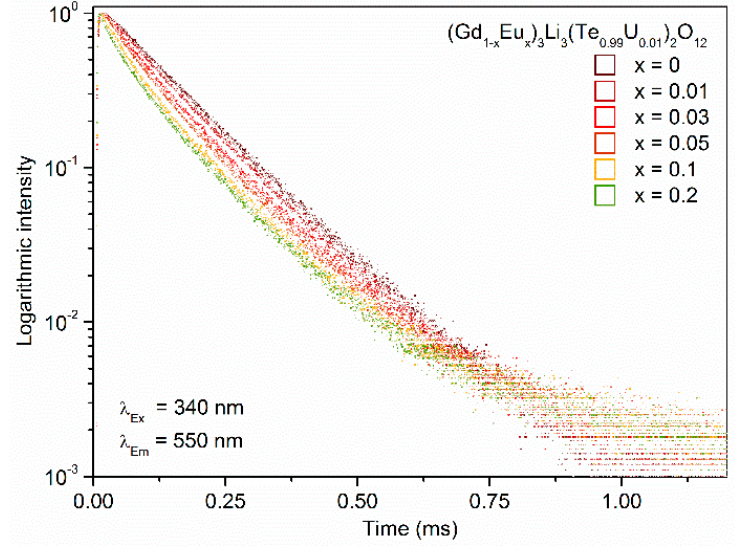
Figure 10. Fluorescence lifetime curves of (Gd 1 − x Eu x ) 3 Li 3 (Te 0.99 U 0.01 ) 2 O 12 with 0 ≤ x ≤ 0.2 upon 340 nm excitation while monitoring the U 6+ emission at 550 nm. Table 2. Fluorescence lifetimes τ 1 and τ 2 , as well as averaged lifetimes τ , of the U 6+ emission in